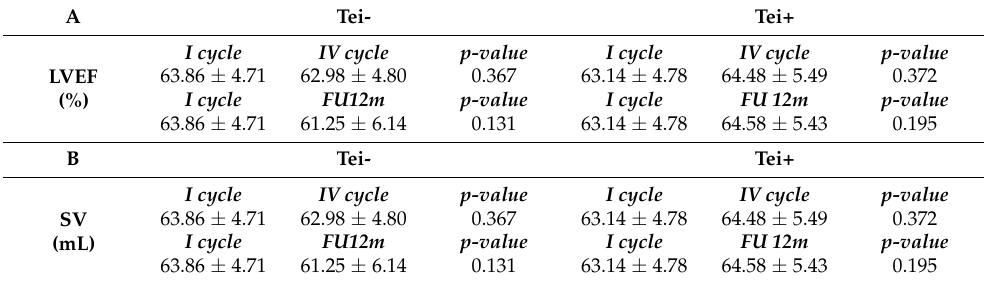
Table 4. Changes of LVEF (A) and stroke volume (SV) (B) during chemotherapy and follow-up.